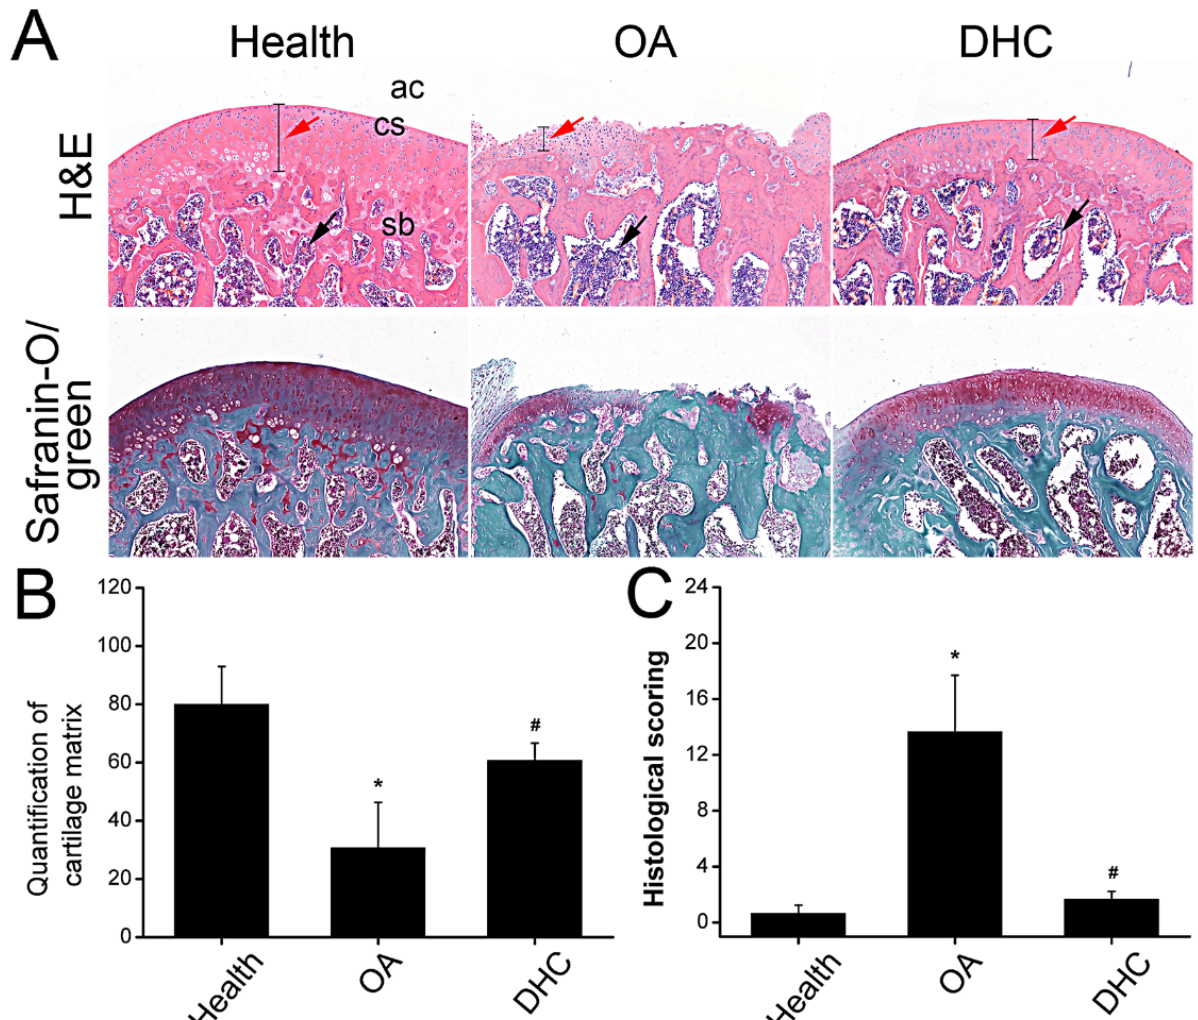
Figure 6. Dehydrocorydaline (DHC) attenuated complete anterior cruciate ligament transection (ACLT)-induced OA progression. ( A ) Cartilage was stained by H&E and safranin-O/fast green (10×). Ac: articular cavity; cs: cartilage surface; sb: subchondral bone. Red arrow: thickness of the cartilage; black arrow: inflammatory cell infiltration. The quantified results of ( B ) cartilage matrix and ( C ) OA histopathology assessment. Data are presented as mean ± SD. *, p < 0.05 compared to the healthy group. #, p < 0.05 compared to the OA group.